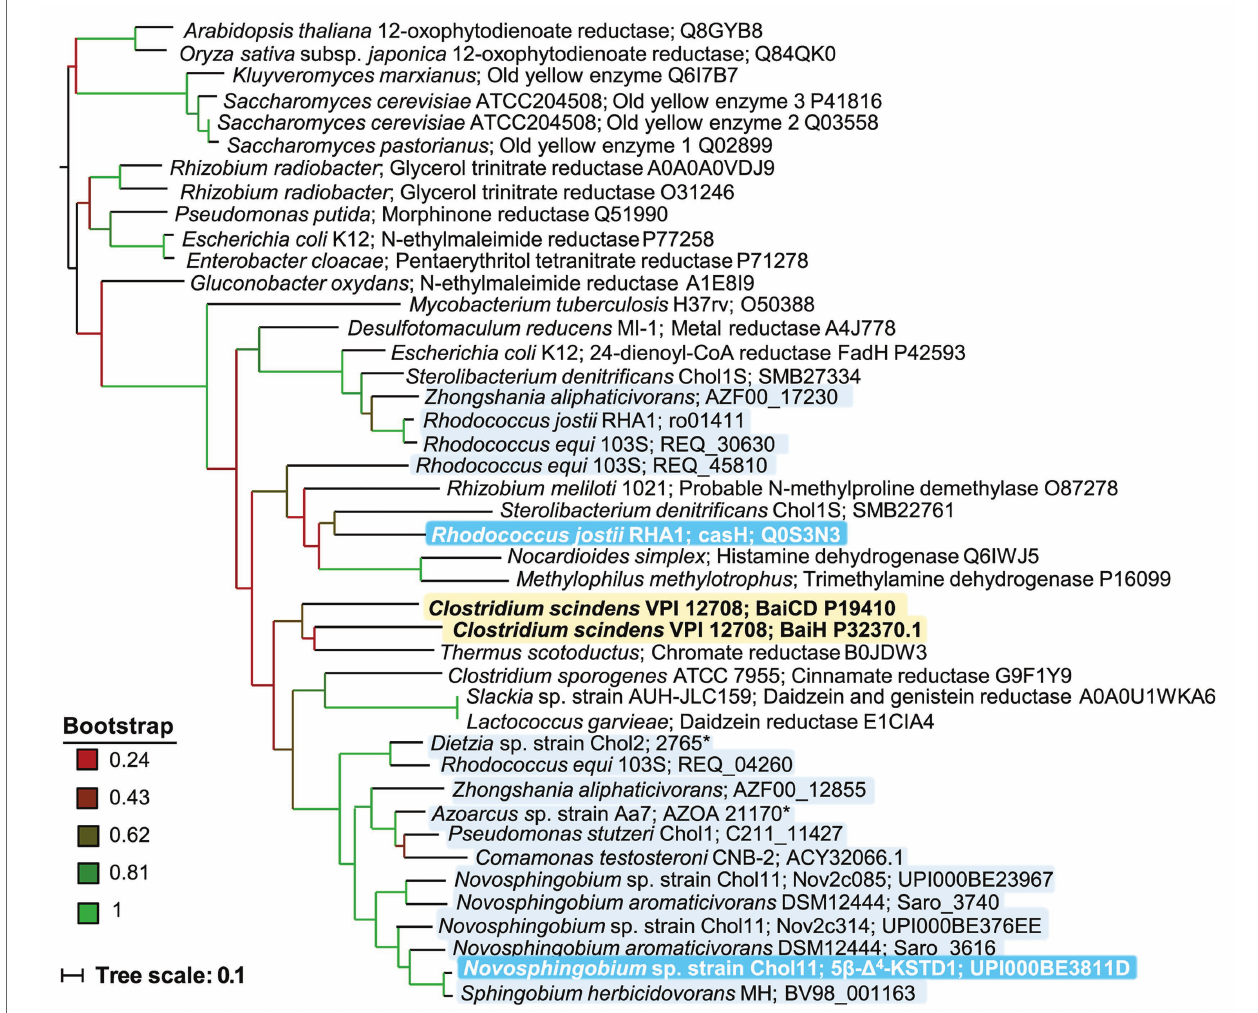
FIGURE 11 | Phylogenetic tree of homologs of 5 β - Δ 4 -KSTD1 and further enzymes from the old yellow enzyme family. The tree was constructed based on ClustalW alignment and maximum parsimony method. Branch colors indicate bootstrap values as indicated. Proteins were chosen from BLAST searches among well characterized proteins with verified function or structure or from known bile-salt degrading bacteria. Yellow shading: Enzymes with confirmed 5 β -bile-salt Δ 4 - dehydrogenase function in bile-salt dehydroxylating bacteria, light blue shading: enzymes from bile-salt degrading bacteria, dark blue shading: enzymes from bile- salt degrading bacteria with confirmed 5 β -bile-salt Δ 4 -dehydrogenase